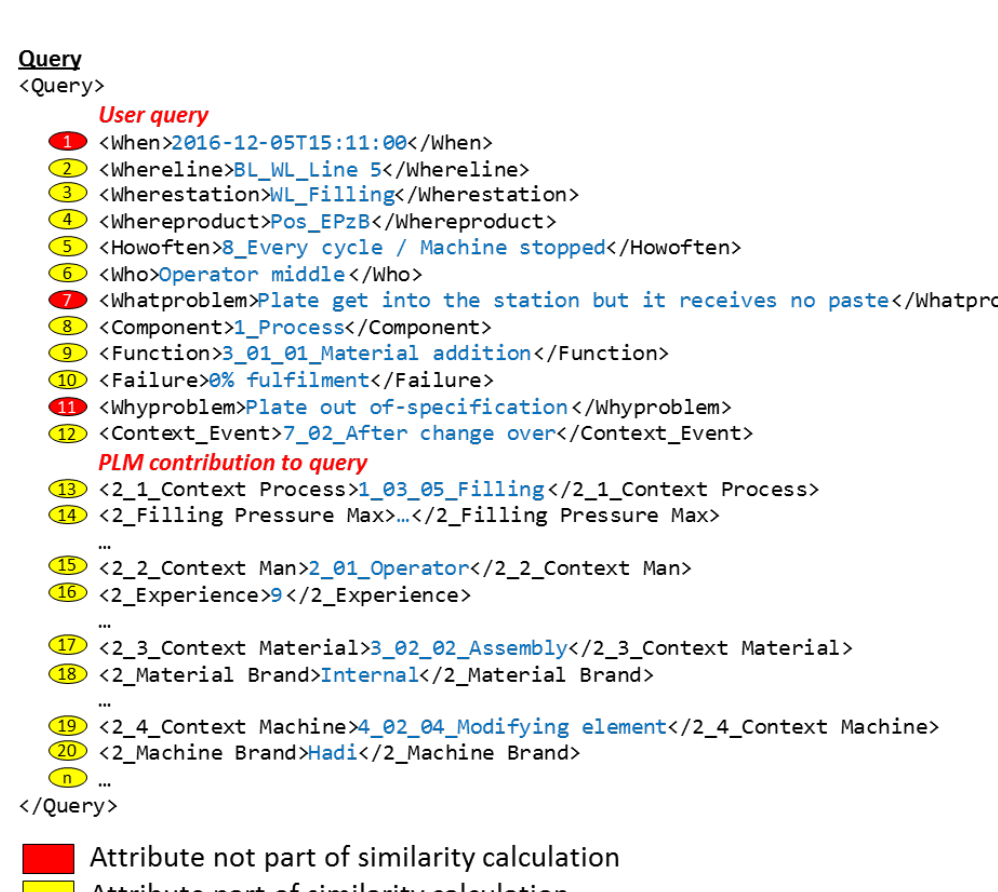
Figure 10. Example of query.